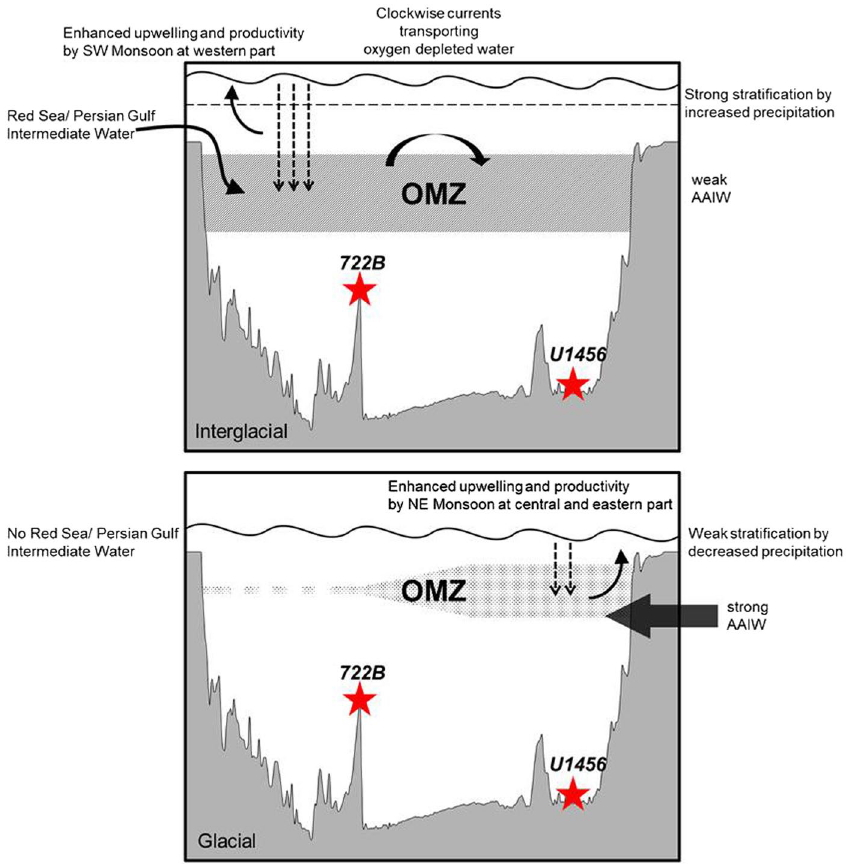
Figure 4. Model of interglacial-glacial denitrification change in association with development of the OMZ in the Arabian Sea. The intensity of the OMZ differs between interglacial and glacial periods 10 . A thicker OMZ and intensified denitrification occurred during interglacial periods, and while the opposite occurred during glacial periods. Because the seasonal OMZ during the glacial periods was weak, denitrification collapsed in the Western Arabian Sea. In contrast, the perennial OMZ has maintained strong denitrification in the Eastern Arabian Sea as indicated by δ 15 N values greater than